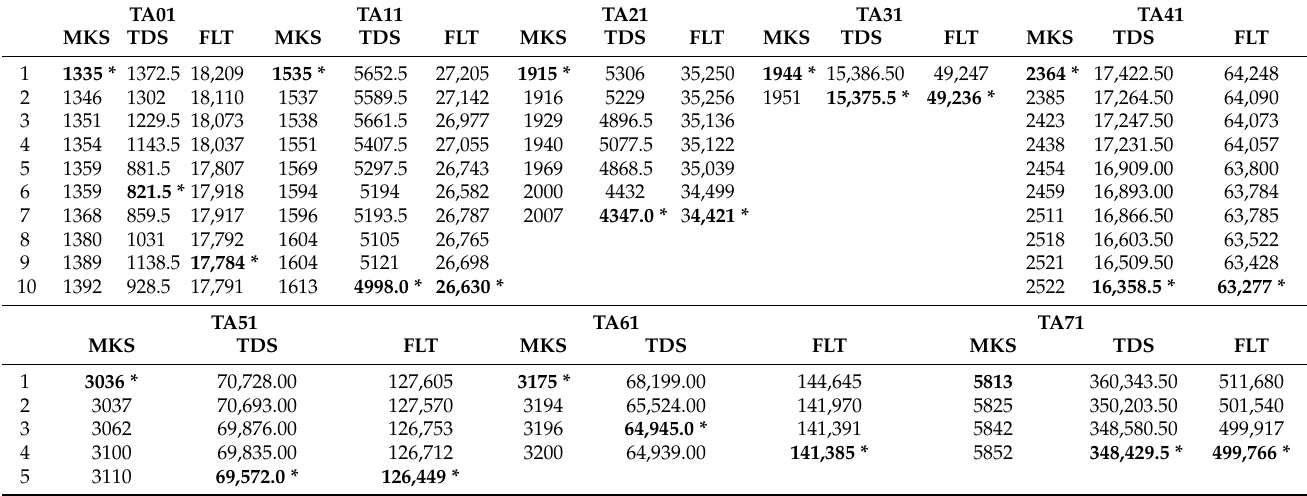
Table A12. Non-dominated solutions obtained by SS/CMOSA for the JSSP instances proposed by [41].